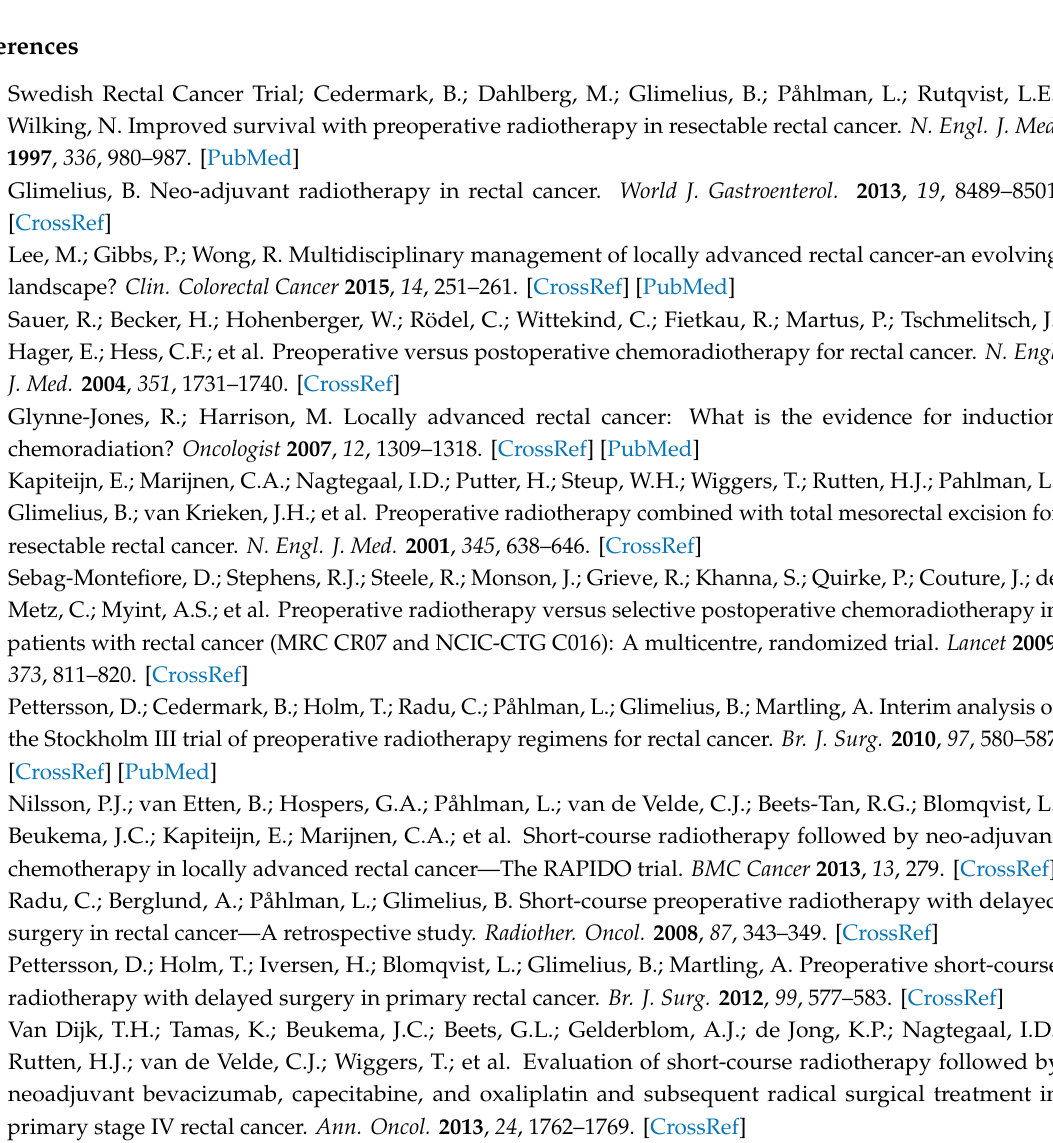
Figure S1: The colony formation study with 200 and 500 cells seeded per well; Figure S2: Flow cytometry apoptosis analysis by annexin V staining; Figure S3: Expressions of apoptosis-, mTOR signaling pathway-, angiogenesis-, DNA-DSB repair-, and DNA damage-related molecules in BEZ235 + mBEZ235 treatment group; Figure S4: Maintenance BEZ235 treatment significantly inhibited CRC xenograft tumor growth when compared to control group; Figure S5: Expression of apoptosis-, mTOR signaling pathway-, DNA-DSB repair-, DNA damage-, and angiogenesis-related molecules in CRC xenograft tissue following BEZ235 + mBEZ235 treatment by immunohistochemistry; Figure S6: Protein expression levels following each treatment were evaluated in HCT116 xenograft tissue via western